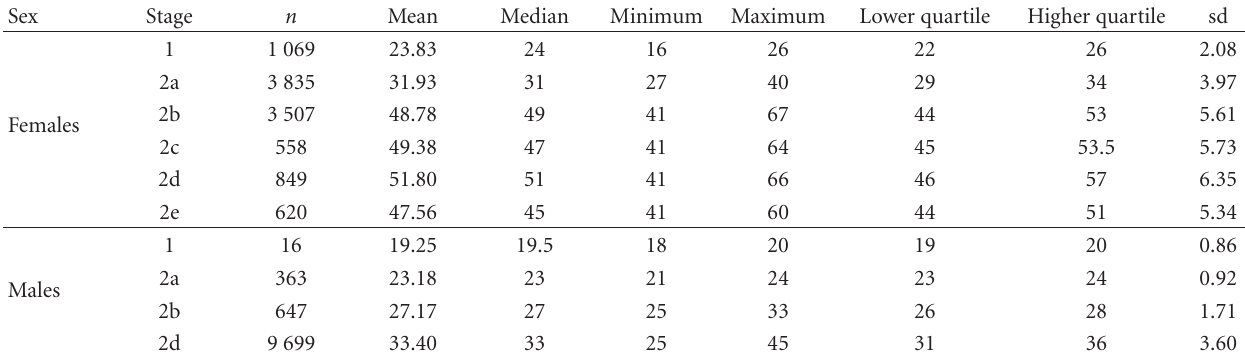
Table 2: Length composition characterization of Aristaeomorpha foliacea according to the box plot approach, by stage, sex, and years com- bined.